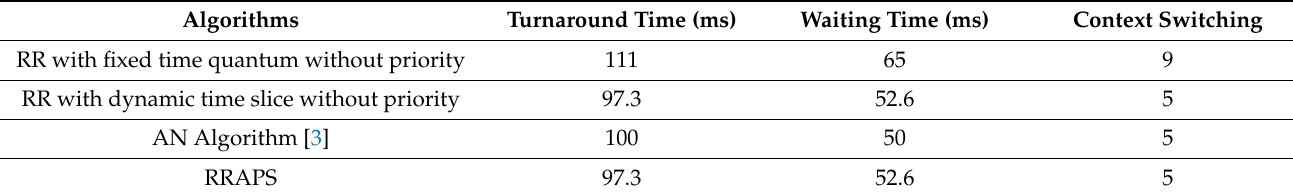
Table 2. Comparison of Case 2 between different algorithm